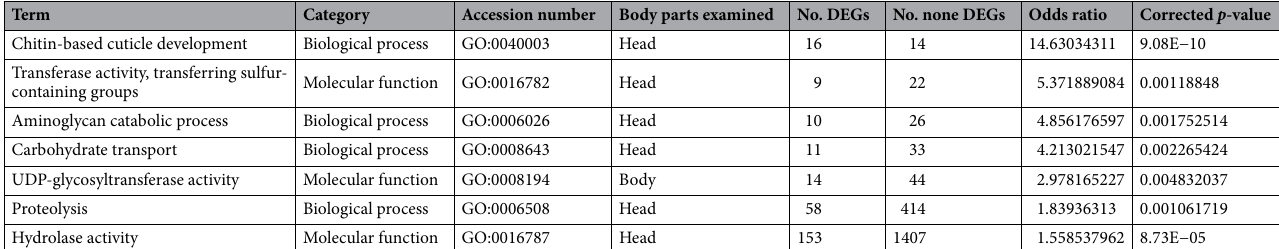
Table 3. Gene Ontology (GO) terms specifically observed during the nymph-nymphoid